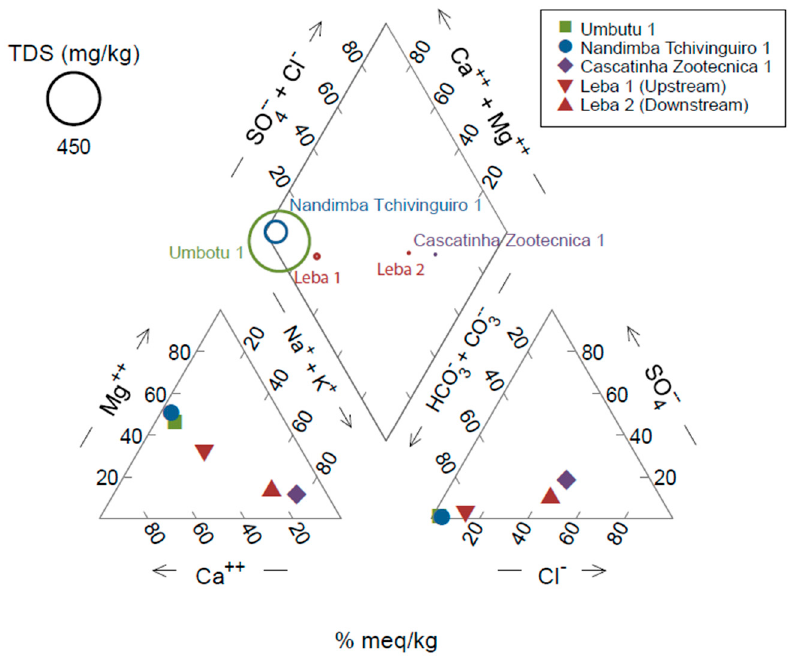
Figure 5. Piper diagram of sites made using Geochemist Workbench with total dissolved solids (TDS) represented by the size of the circle in the diamond.